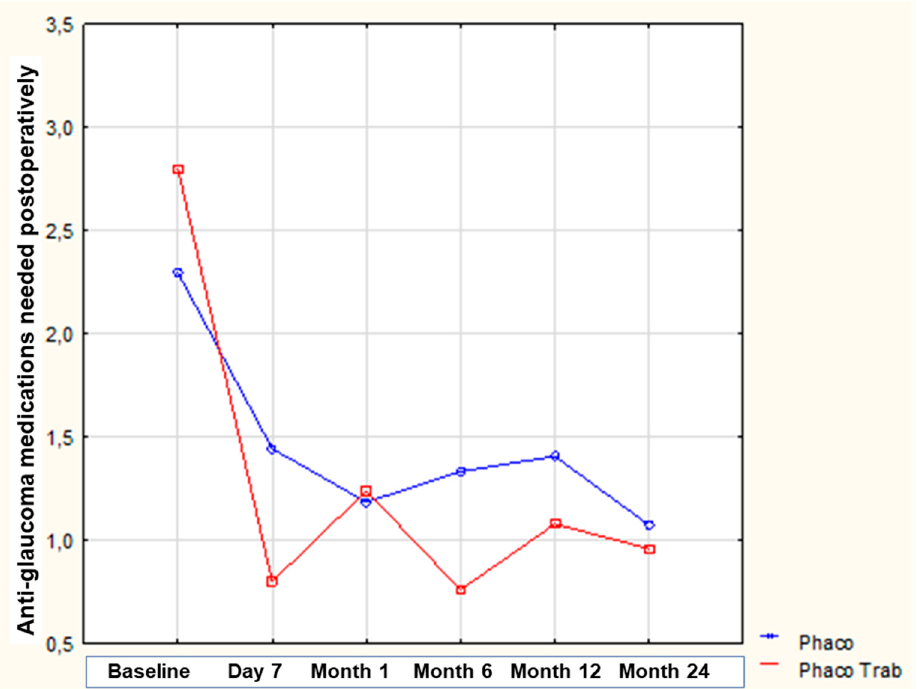
Figure 2. Evolution of anti-glaucoma medications over time between the two groups.